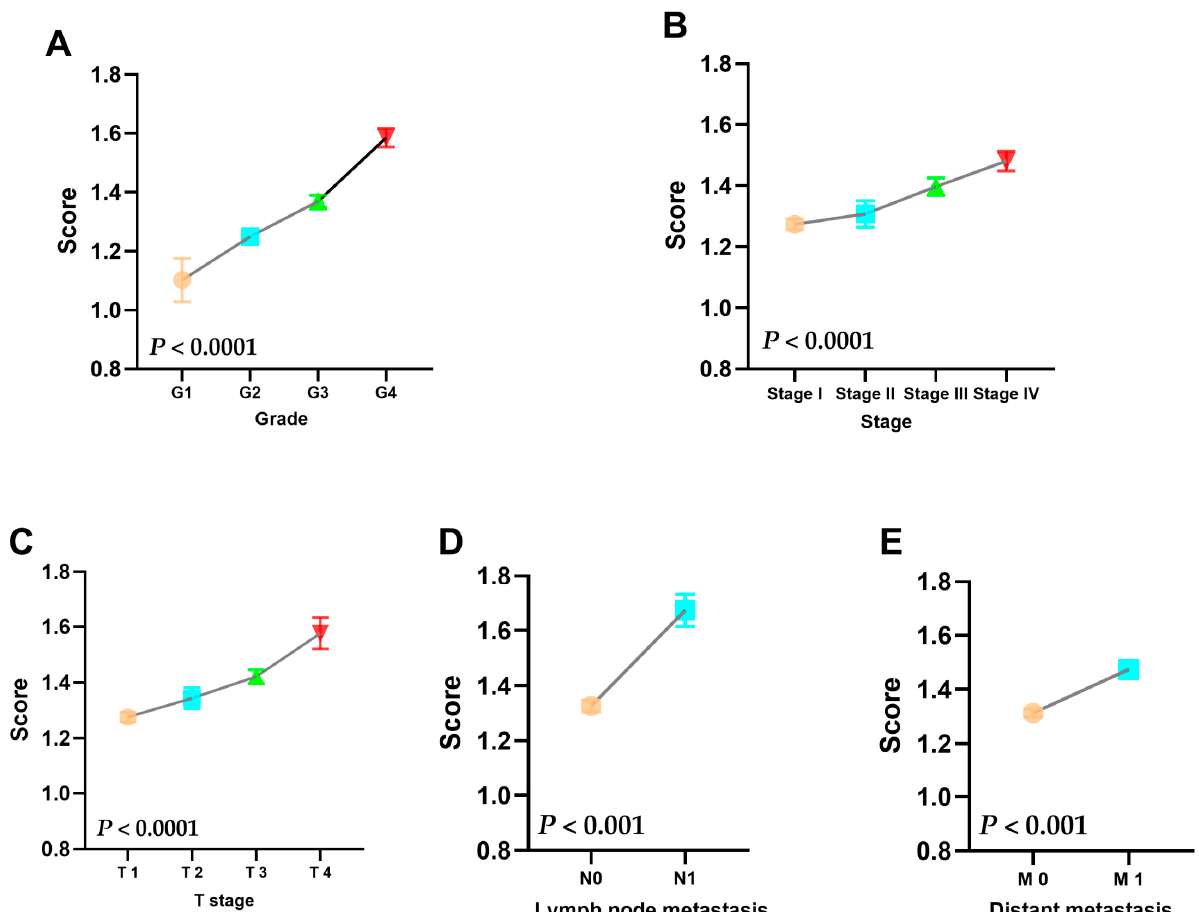
Figure 4. Relationship between risk score and different clinicopathological information groups based on TCGA cohort. ( A ) The relationship between risk score and Grade. ( B ) The relationship between risk score and Stage. ( C ) The relationship between risk score and T stage. ( D ) The relationship between risk score and lymph node metastasis. ( E ) The relationship between risk score and distant metastasis.